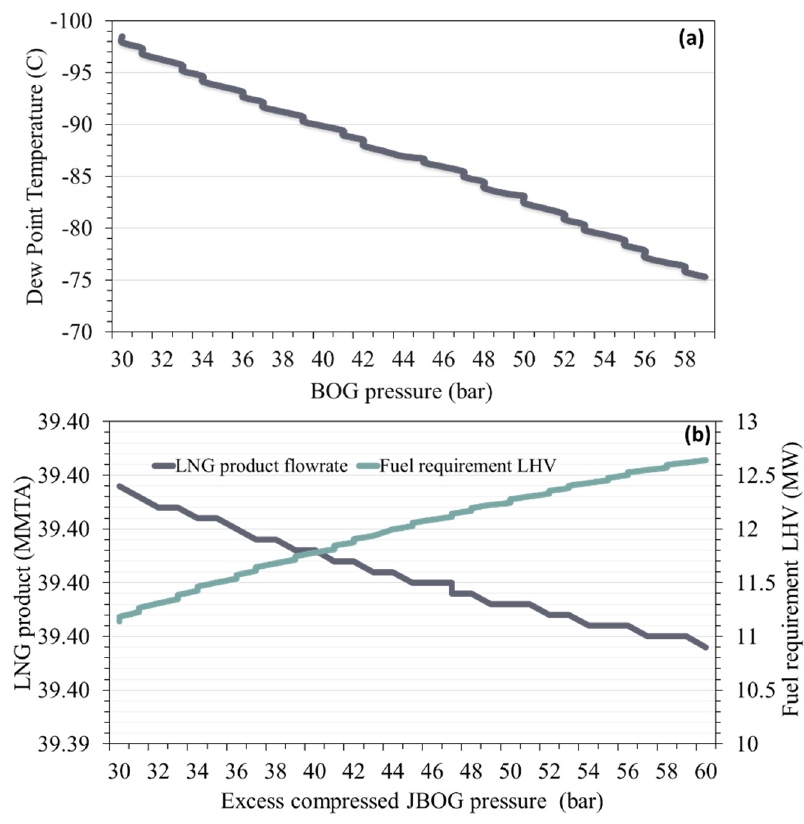
Figure 4. Effect of JBOG compression before liquefaction, ( a ) variation of BOG dew point temperature, ( b ) effect on LNG product and fuel requirement.